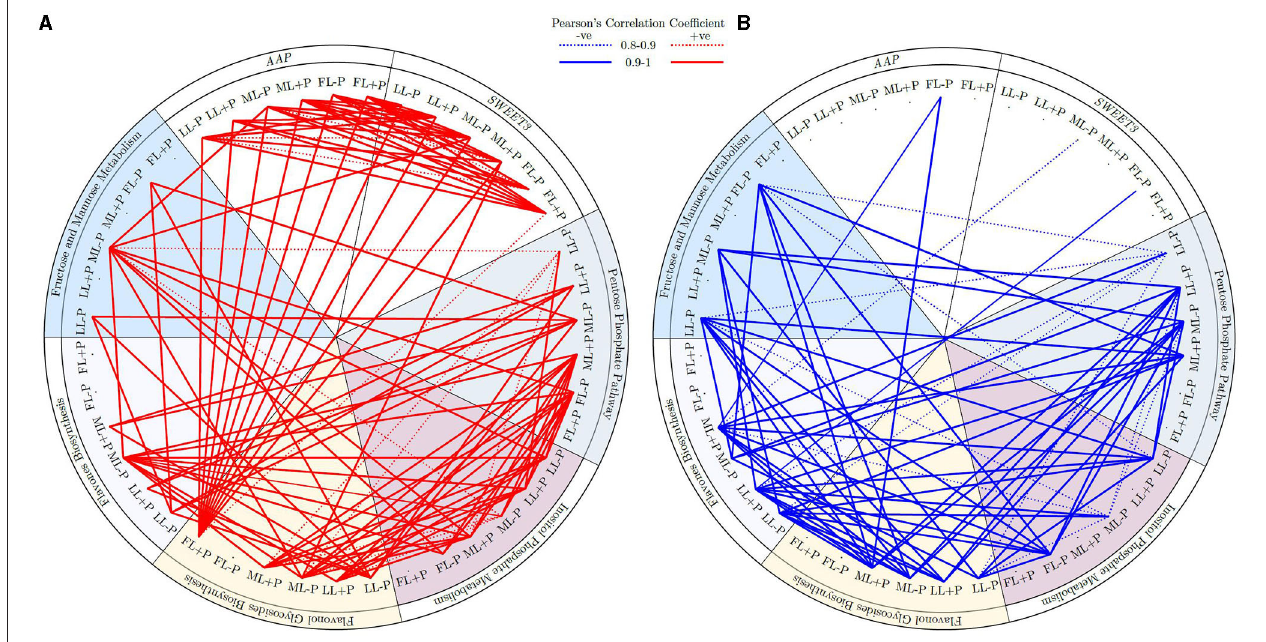
FIGURE 9 | (A,B) Circular representation of the correlation between genes under different P levels and light